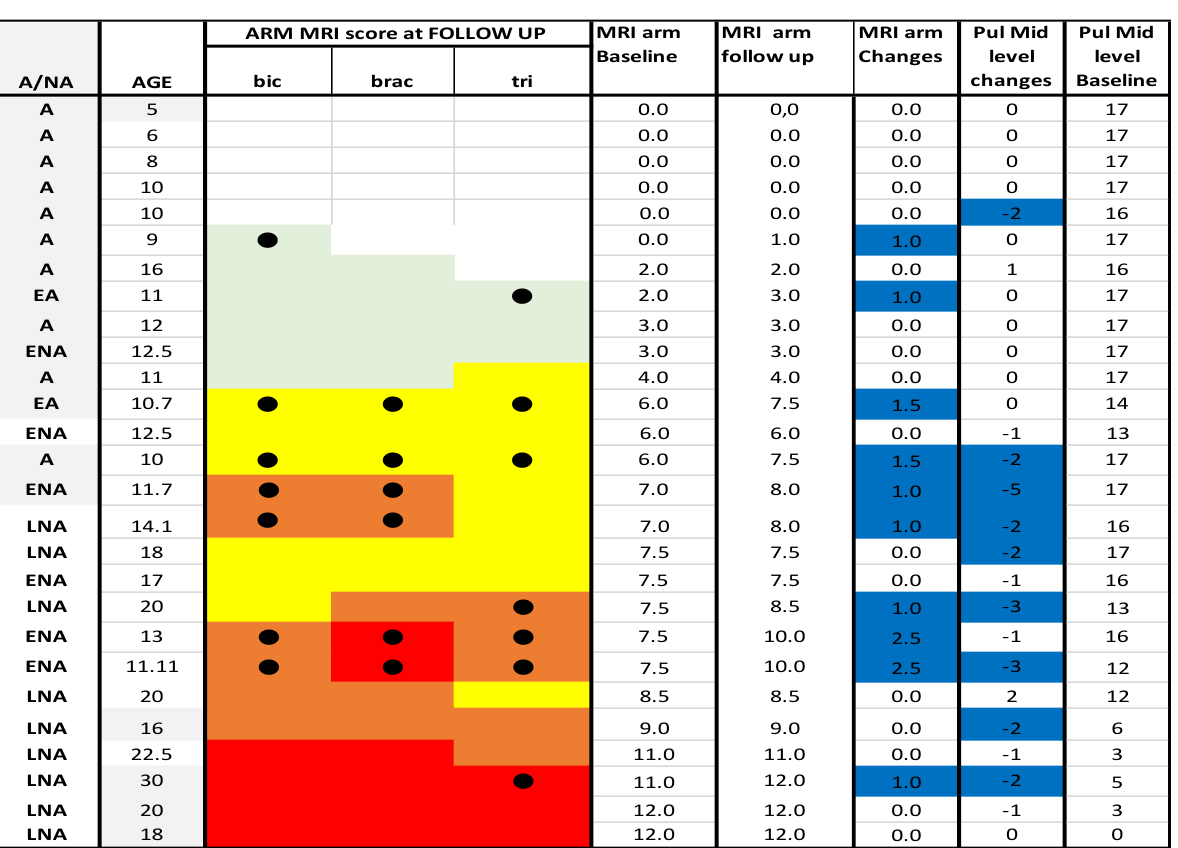
Figure 7. showed scores in muscle MRI at arm level at baseline and at follow up according to age.